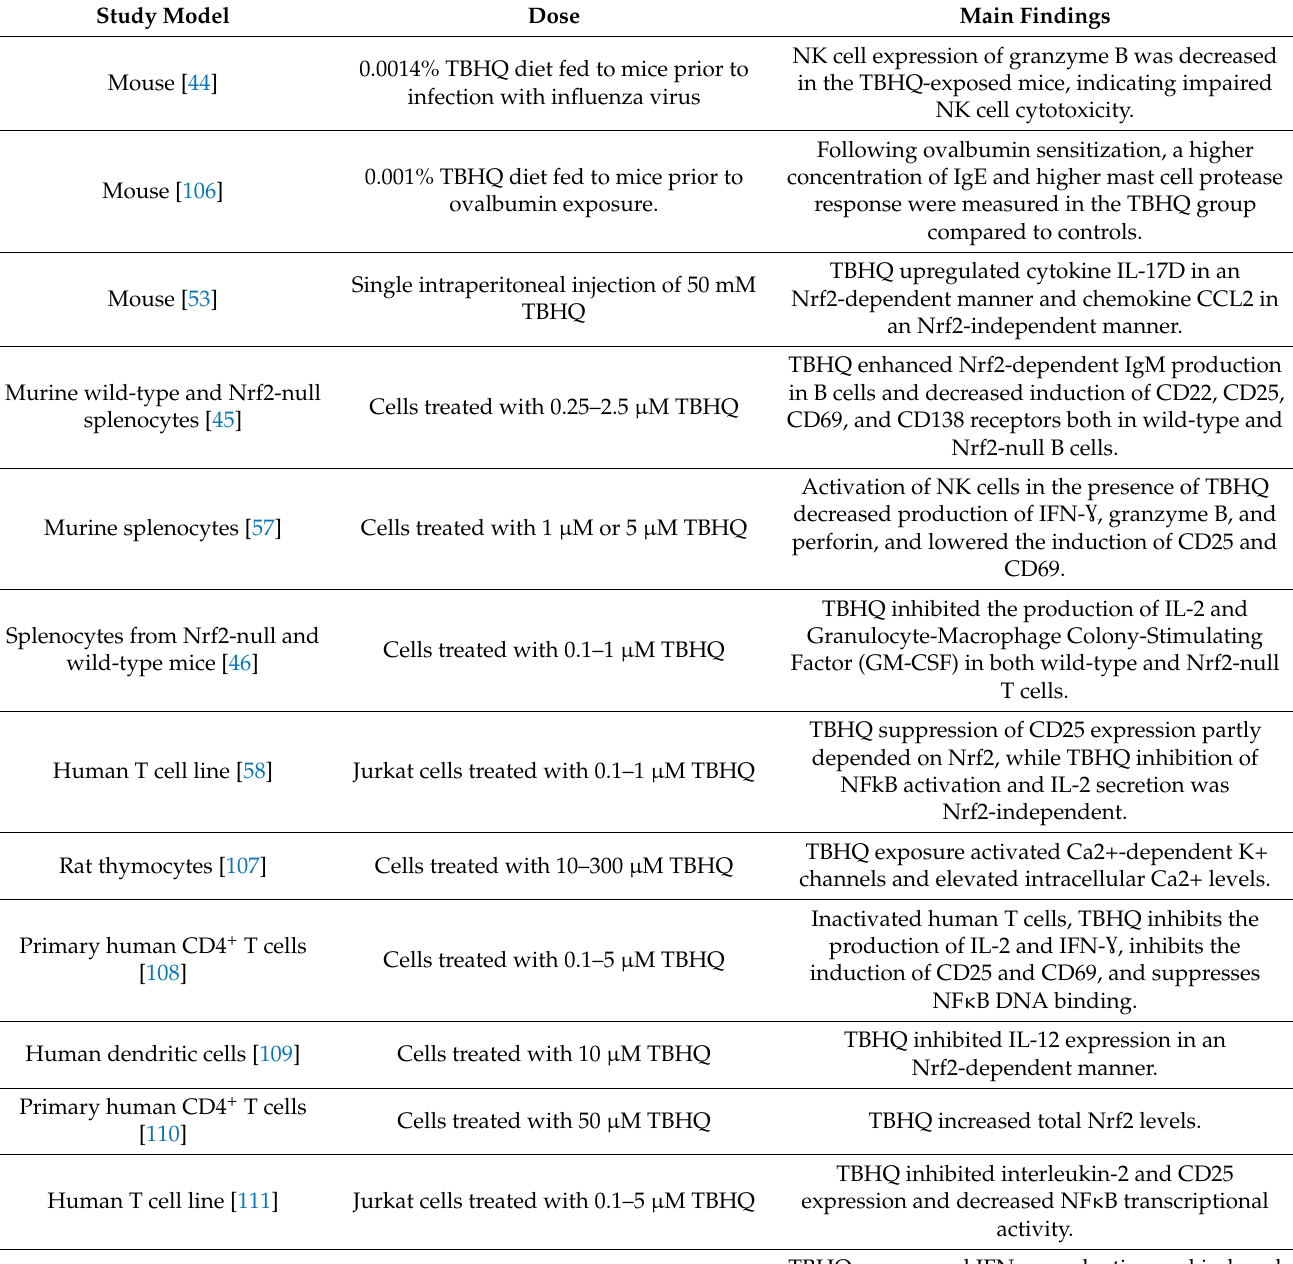
Table A2. TBHQ activity reported in immunological studies published between 2011 and 2020.